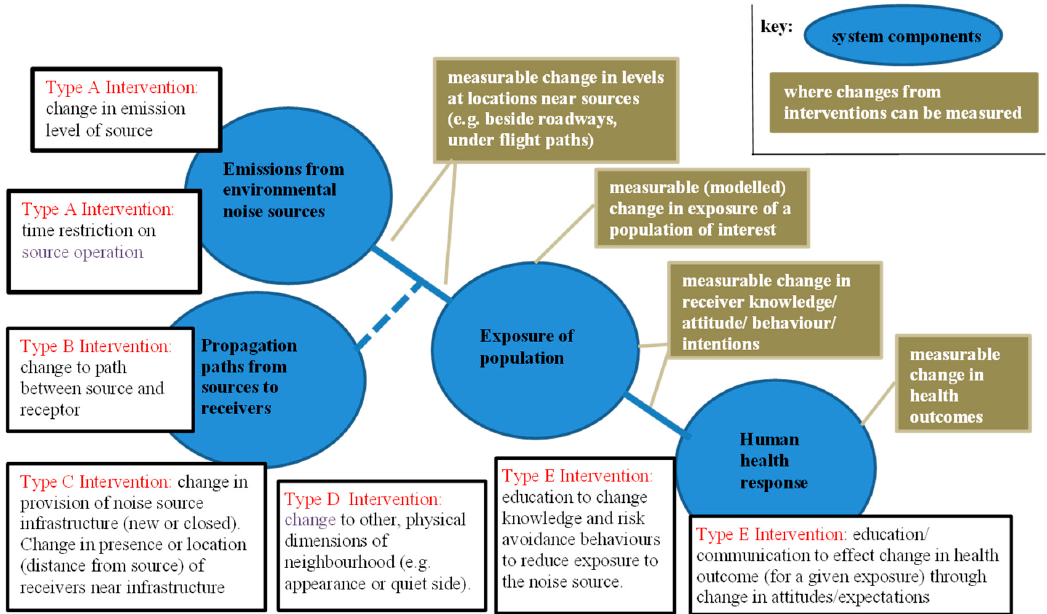
Figure 1. Intervention framework showing: system components of the path between environmental noise and human health, where different types of noise intervention potentially act along that path, and points along the pathway where changes resulting from interventions can be measured. Table 1. Categorisation of Noise Interventions.